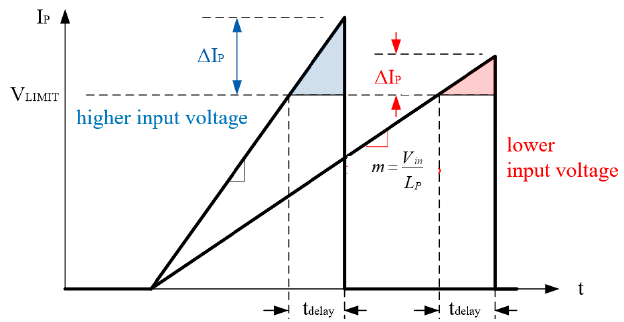
Figure 2. Overflow current with different input voltage